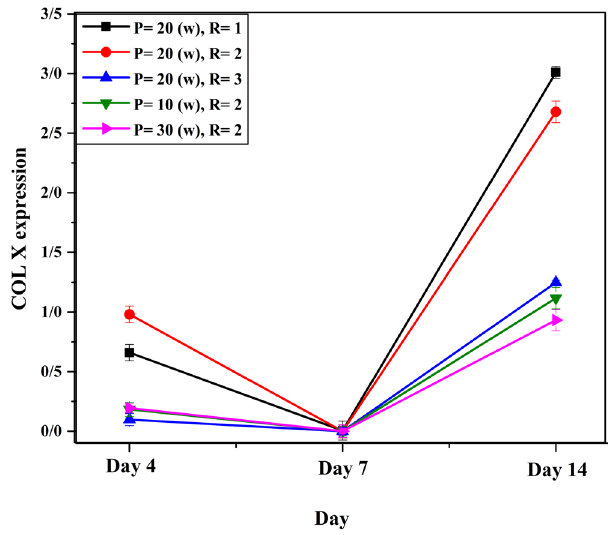
Figure 12. Col X extraction versus day for different L-PPA: N